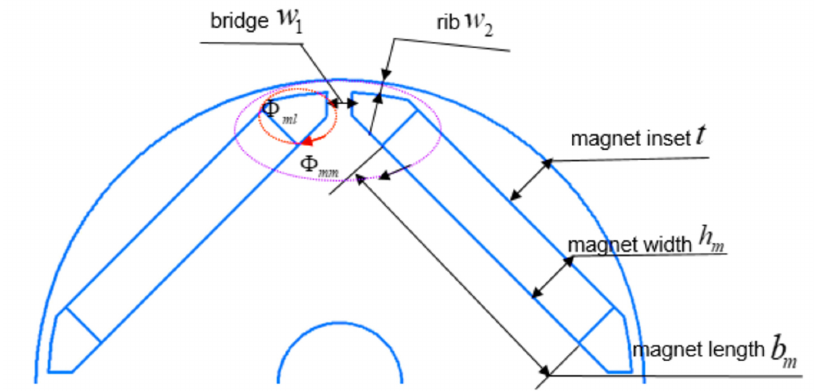
Figure 5. Magnet and flux guide